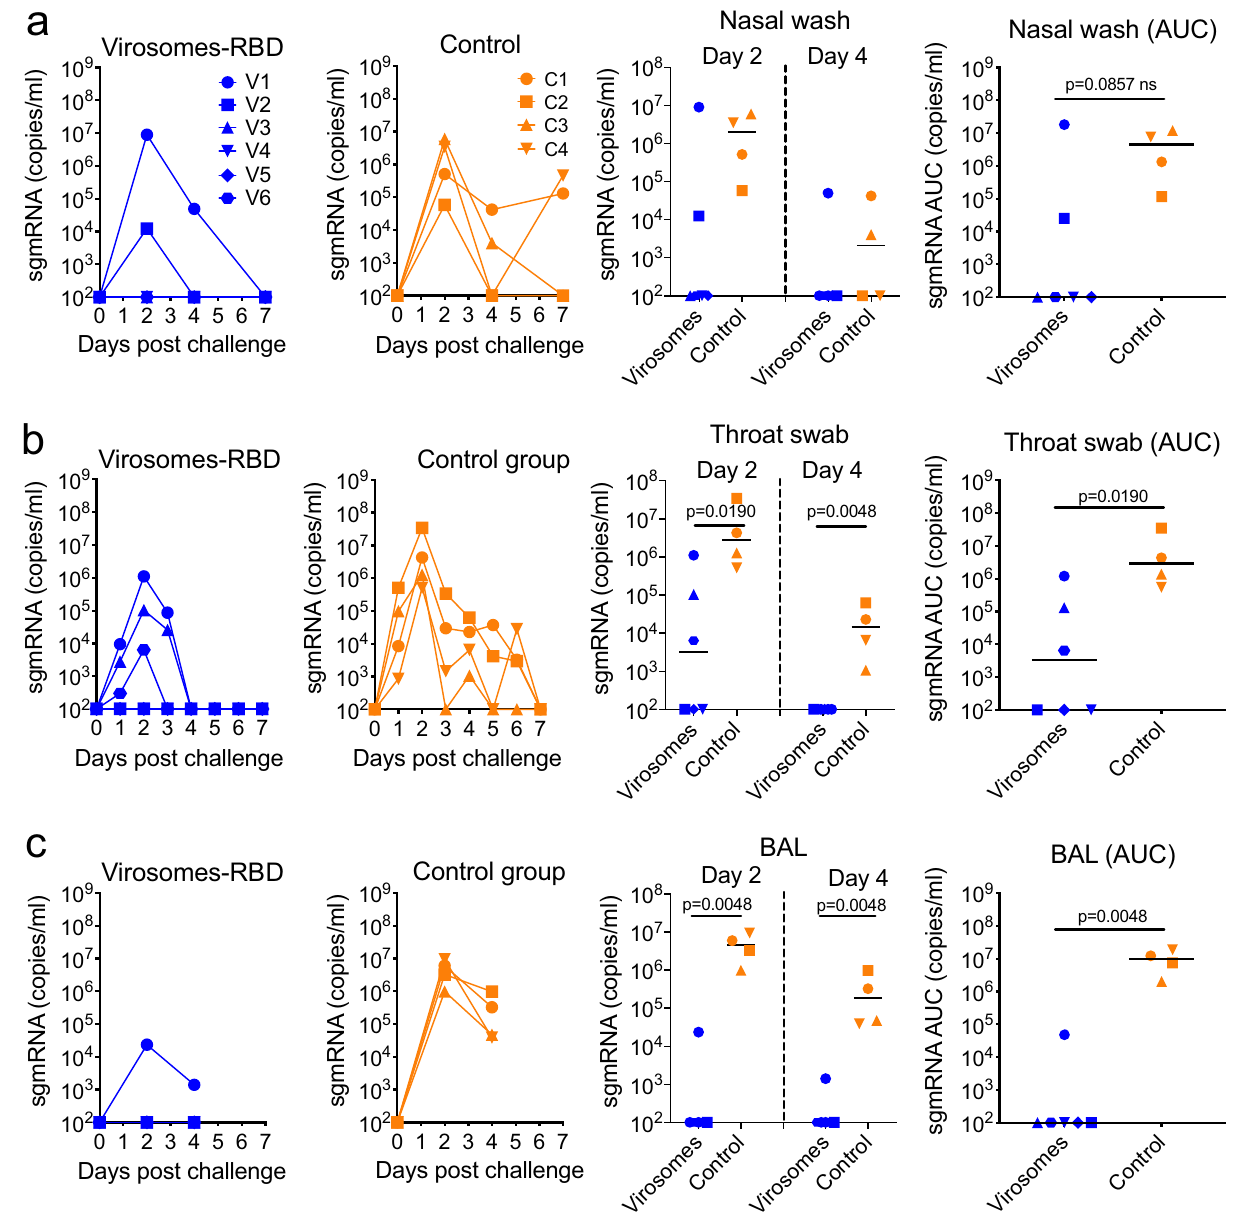
Figure 5. Control of SARS-CoV-2 replication by virosomes-RBD vaccine. SARS-CoV-2 sgRNA load (copies/ mL) and area under the curve (AUC) for the sgRNA load (copies/mL) in nasal washes ( a ), throat ( b ) and lung bronchoalveolar lavages (BAL) (c) of virosomes-RBD immunized macaques (blue, left panels) and control animals (orange, middle panels) at different days post-challenge. Each animal is represented by a symbol. All data are shown relative to the day of challenge (day 0, day of virus administration) done at day 56 of the study. Panels on the right show statistical evaluation on SARS-CoV-2 sgRNA load in nasal washes on day 2 and 4 (upper right), in the throat (middle right panel) and in BAL fluid on day 2 and 4 (lower right panel). Median values are indicated by horizontal black lines. Significant differences between the groups are indicated in the graph by a horizontal line and p -value (Mann–Whitney